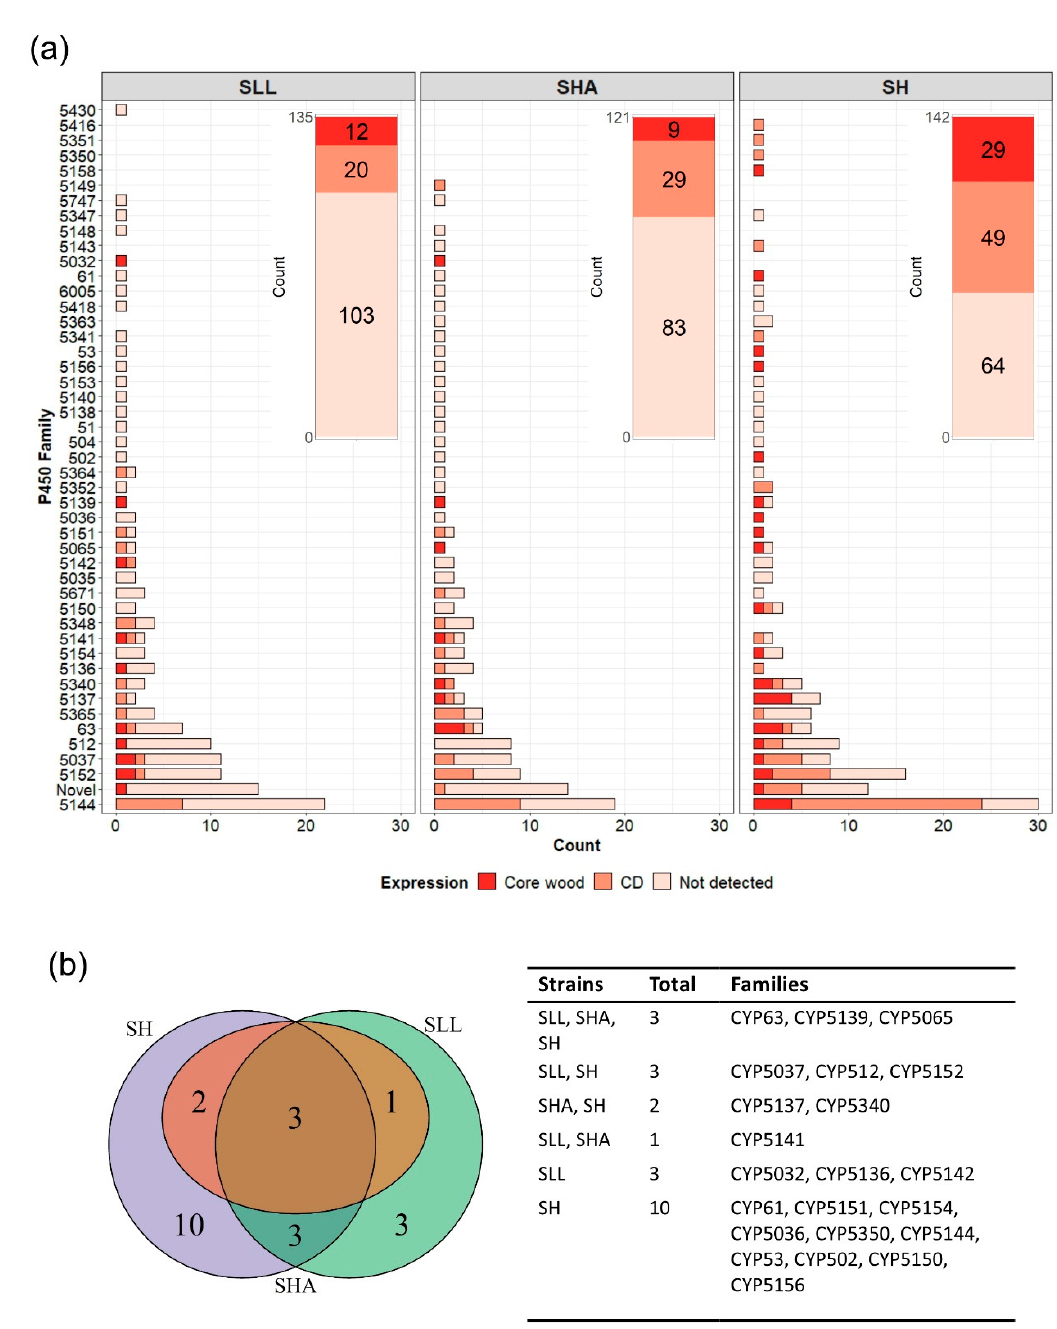
Figure 5. Core wood P450 transcripts for S. lacrymans var. lacrymans (SLL), S. lacrymans var. shastensis (SHA) and S. himantioides (SH). ( a ) Predicted P450 families that showed significant up-regulation during growth on media supplemented with wood (either pine or spruce) compared to CD agar for each of the Serpula strains. P450 families for which expression was not detected under the conditions tested are also shown. The stacked bar insert (top right of each panel) shows the breakdown in terms of the total P450 count falling under each category of expression. ( b ) Venn diagram of the core wood P450 transcripts for each strain with the accompanying table to indicate the P450 families identified.